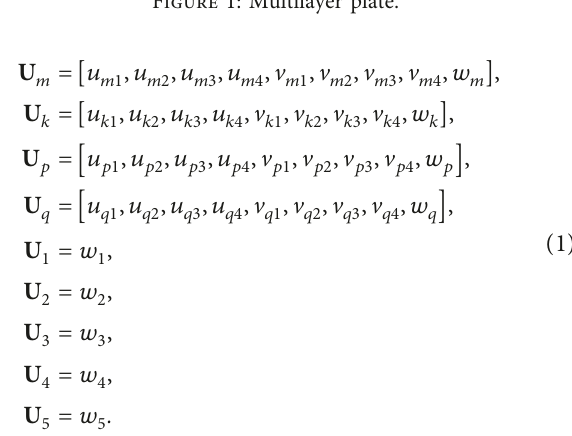
Figure 1: Multilayer